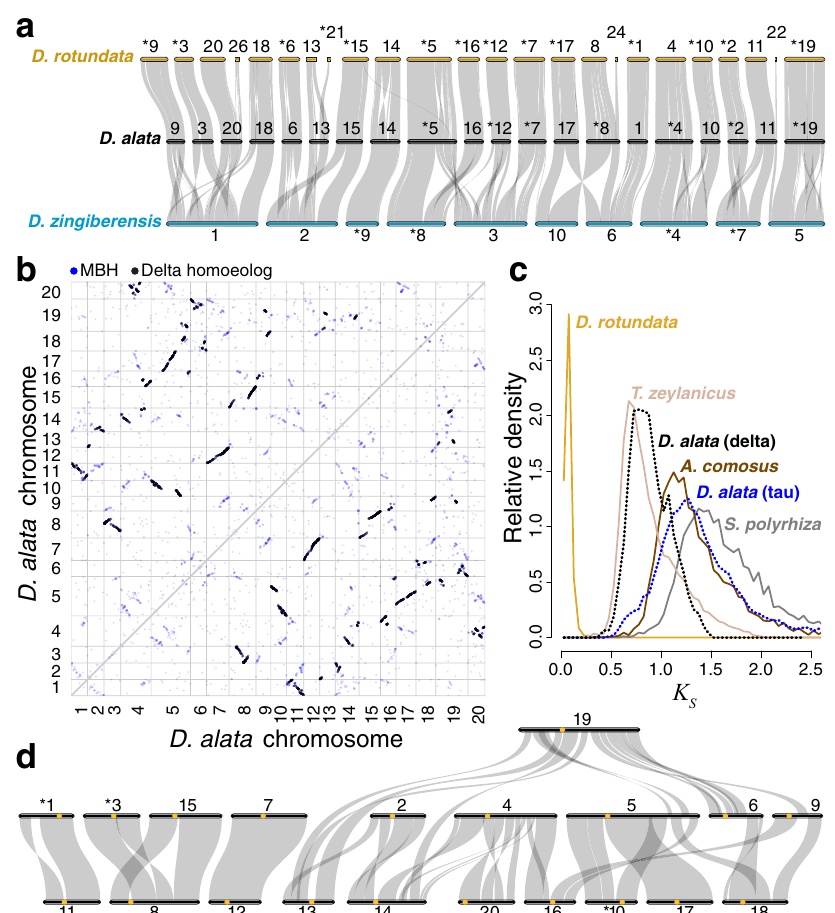
Fig. 2 Dioscoreaceae chromosome evolution. a Ribbon diagram demonstrating conserved chromosomal synteny and large-scale segmental collinearity (semi-transparent gray ribbons) between Dioscorea alata (black horizontal bars), D. rotundata (gold), and D. zingiberensis (cyan) one-to-one orthologous gene pairs. Only D. rotundata sequences with fi ve or more collinear genes are shown. To improve visual clarity, some chromosomes, marked with asterisks, were reverse complemented with respect to their assembled sequences. Chromosome sizes are proportional to the number of annotated genes. b Dot plot showing evidence of two whole-genome duplications exposed by TDa95/00328 intragenomic comparison. Each point represents a mutual best-hit (MBH) gene pair and each white box (outlined in grey) represents the intersection of two chromosomes. Homoeology from the recent Dioscoreaceae delta duplication is shown in black and the ancient, core monocot tau duplication can be seen as clusters in blue (see also, Supplementary Fig. 9). c The synonymous substitution rate ( K S ) histograms for orthologous (solid lines) or homoeologous (dotted lines) gene pairs between D. alata and select species comparators are shown: D. rotundata ( n = 14,889), T. zeylanicus ( n = 9013), D. alata delta ( n = 1578), A. comosus ( n = 6405), D. alata tau ( n = 404), and S. polyrhiza ( n = 4973). The D. alata – D. rotundata ortholog density was rescaled by 0.25 to emphasize other comparisons. d Shared segmental homoeology (semi-transparent gray) between D. alata chromosomes (black horizontal bars) resulting from the delta duplication is depicted with a ribbon diagram, as in panel a , but with putative centromere positions now included as gold circles (Supplementary Data 2). Source data are provided as a Source Data fi